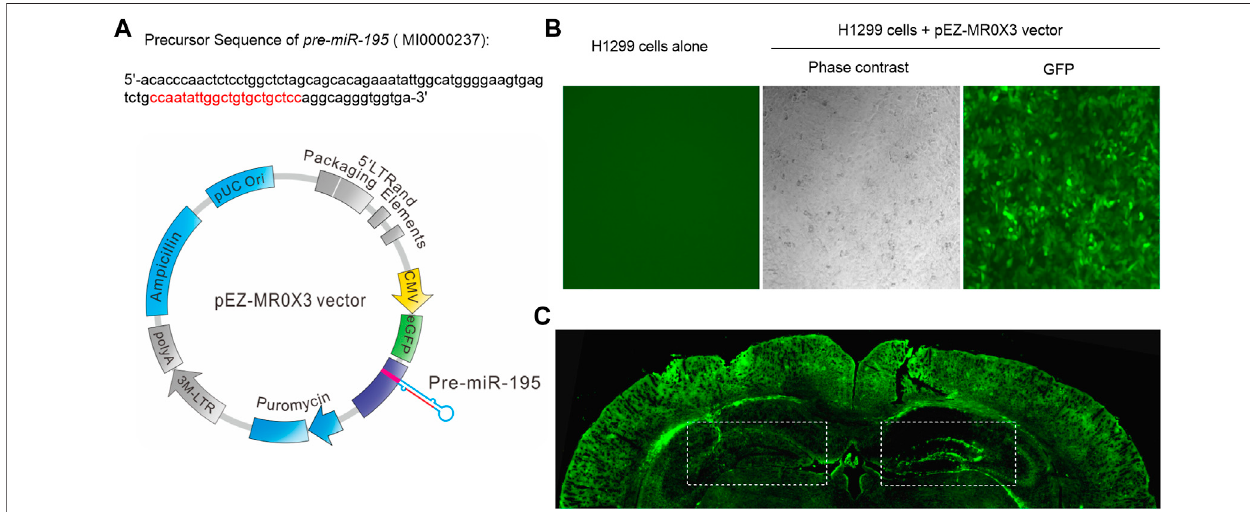
FIGURE2| Plasmidconstructionandtransfectionef fi ciencyevaluation (A) Thestructureoflentiviralvectorcontainingmmu-pre- miR-195 (Lv-pre -miR-195 )andthe precursor sequence of pre -miR-195 (B) H1299 cells (in a 24-well plate) were transfected with 1 μ L pEZ- MR0X3 vector for 3 days, and the expression of green